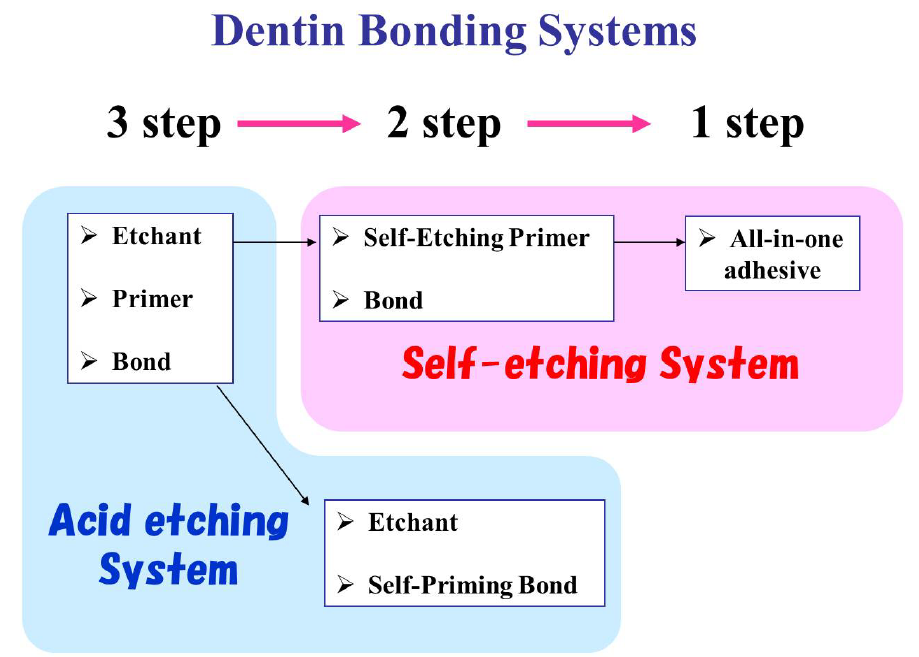
Figure 2. Classification of dentin bonding systems; Dentin bonding systems are improved and